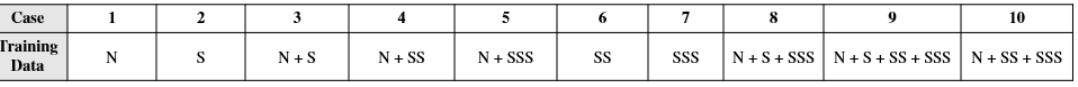
Figure 7. Equivalence between training data used and case of experiment in Section